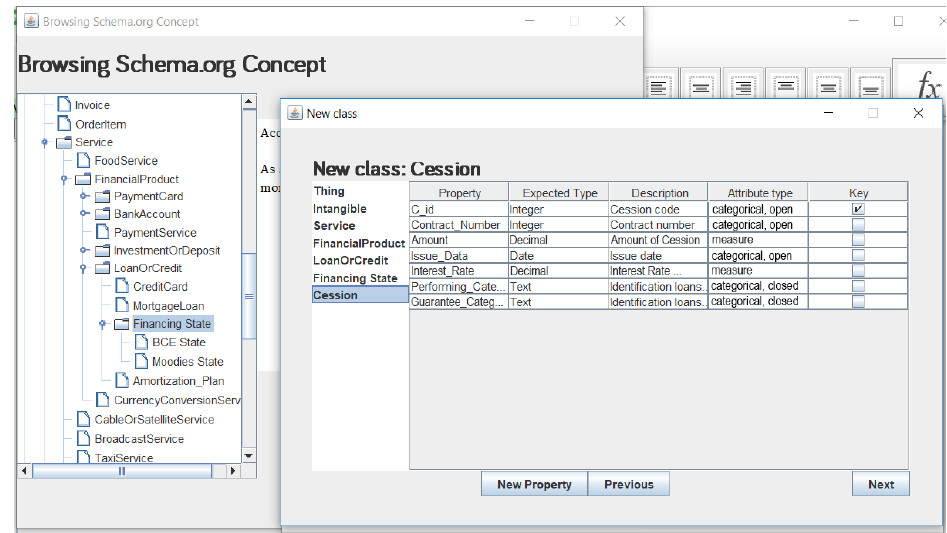
Figure 11. RADAR Knowledge-Base Manager : screenshot of the Class Designer .